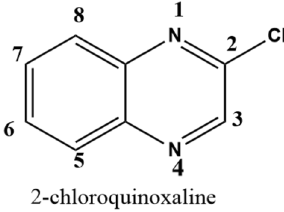
Figure 1. Structure of 2-chloroquinoxaline ( 2Cl-quinox